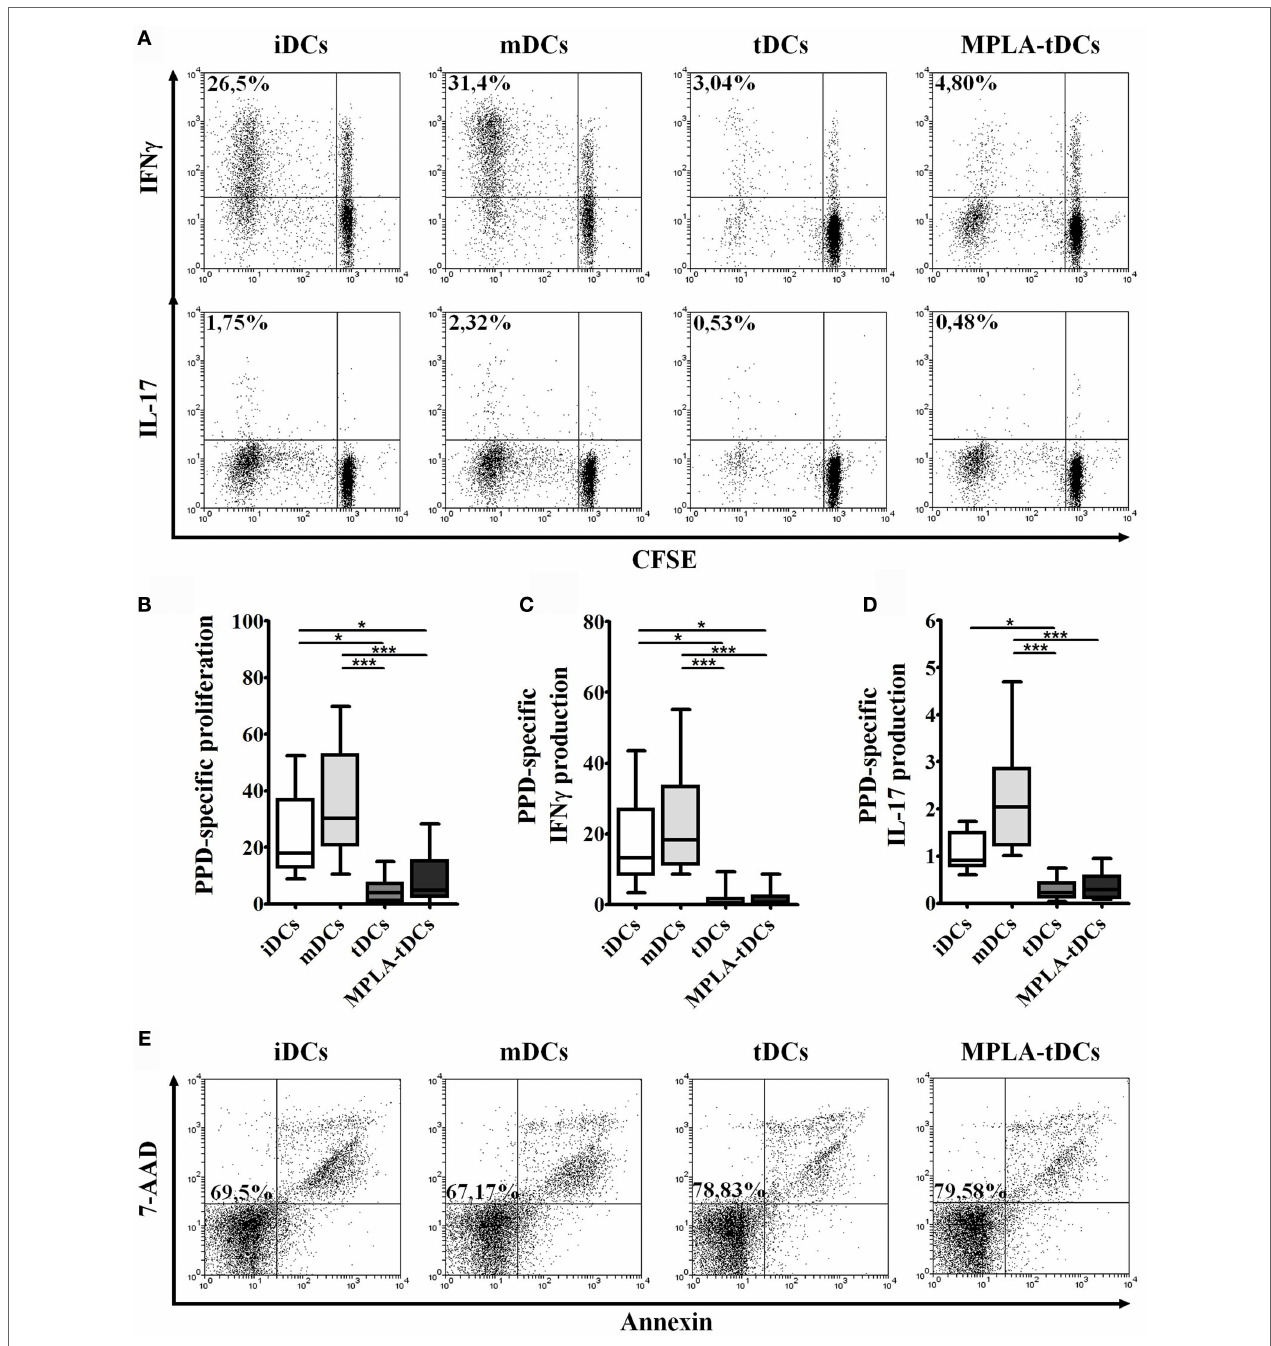
FigUre 2 | MPla-tDcs modulate memory cD4 + T cells responses in an antigen-specific way . For the assessment of their T cell-stimulatory capacity, PPD-pulsed DCs were co-cultured with autologous CFSE-labeled memory CD4 + T cells. Un-loaded DCs were used as control. Data were normalized by subtracting values of unpulsed conditions to antigen-specific conditions. (a) Representative dot plots of IFN- γ (top) and IL-17 (bottom) expression from 10 independent experiments are shown. (B) Proliferation of CD4 + T cells was determined by CFSE dilution through flow cytometry, and graphic representation of normalized data of the percentage of CFSE low in CD4 + T cells is shown. (c) IFN- γ and (D) IL-17 expression was detected intracellularly and analyzed by flow cytometry. Graphic representation of normalized data of the percentage of IFN- γ and IL-17 producing proliferating CD4 + T cells (CFSE low ) is shown. In (B–D) , statistical differences were calculated using Friedman test followed by Duns post-test (* P < 0.05; *** P < 0.001). (e) Representative dot plots of cell viability measured after 6 days of co-culture and expressed as the percentage of annexin-V and 7-AAD-negative cells are